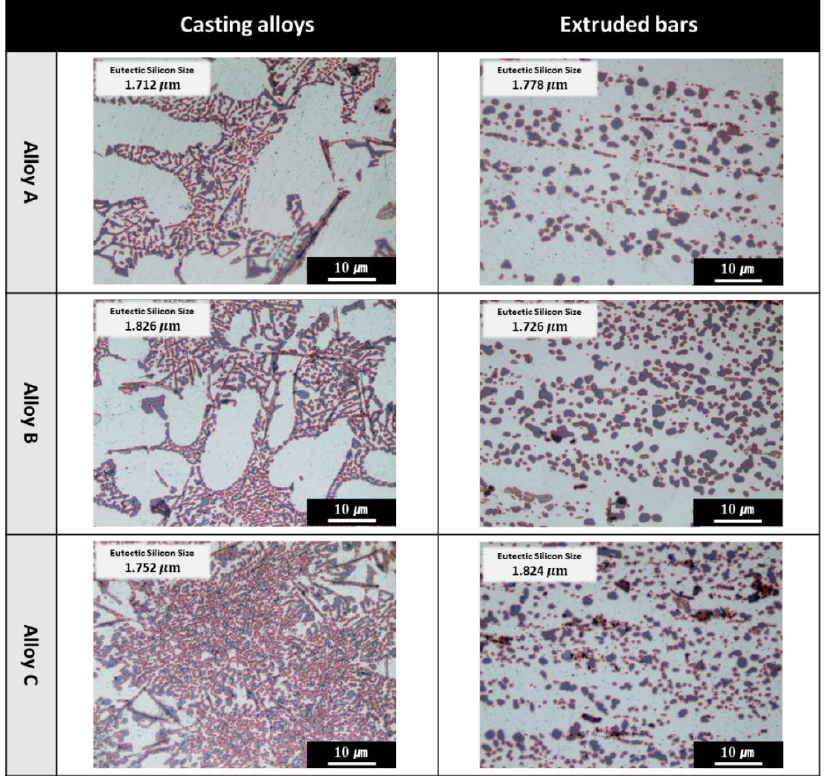
Figure 1. Optical micrographs and particle size analysis of silicon in both casting and extruded Al-XSi-3Cu-0.6Mg-0.5Fe [X = (alloy A): 10; (alloy B): 12.6; (alloy C): 14] alloys.